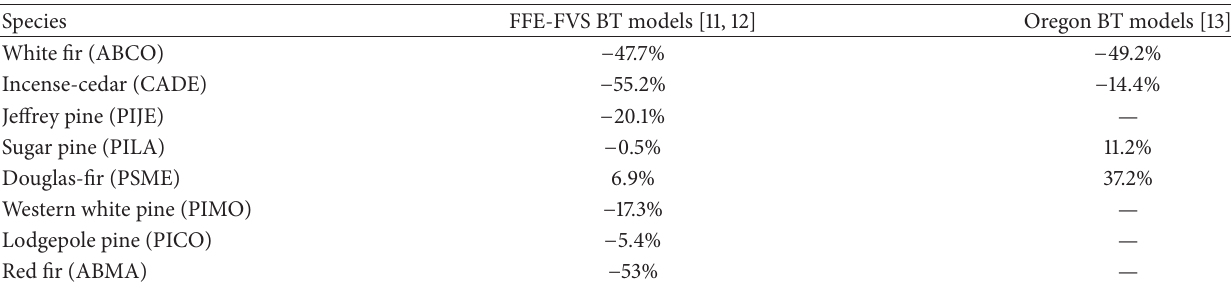
Table 4: Performance of bark thickness (BT) models in the Fire and Fuels Extension for the Forest Vegetation Simulator (FFE-FVS) [11, 12] and Larsen & Hann [13] models for BT in Oregon applied to BT and DBH data for California mixed-conifers. Comparing BT data for Klamath National Forest (KNF), Tahoe National Forest (TNF), Stanislaus-Tuolumne Experimental Forest (STEF), and Sequoia National Forest (SNF) in California against FFE-FVS and Oregon BT model predictions in terms of percent difference between predicted BT and actual BT data calculated as 100 × (predicted-actual)/predicted. Negative percentage indicates underprediction by the FFE-FVS or Oregon